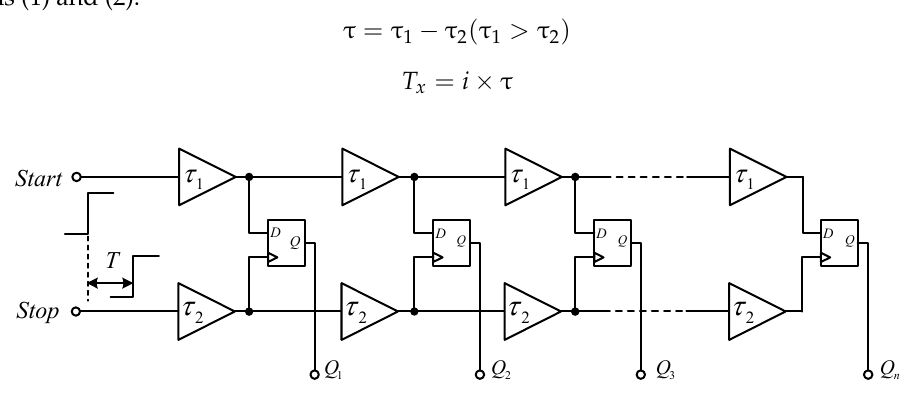
Figure 1. Schematic of a time ‐ to ‐ digital converter (TDC) based on a Vernier delay line.